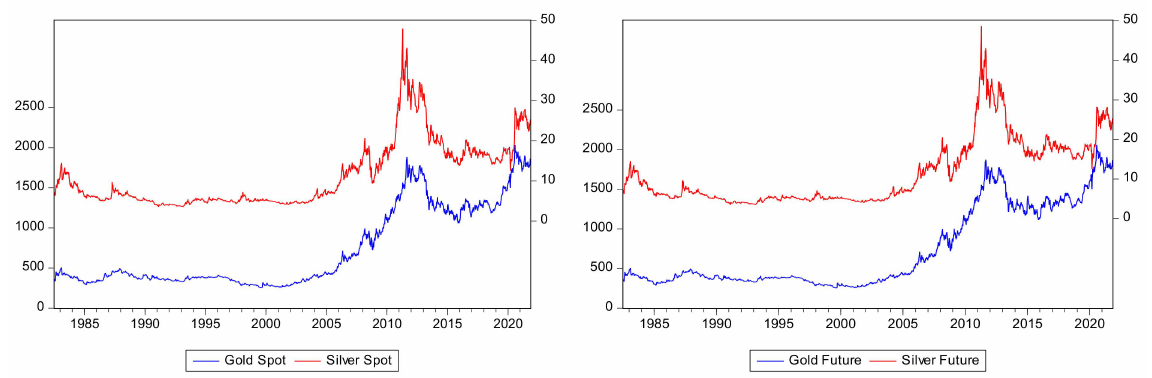
Figure 1. Gold and Silver Spot and Future prices. As we can see both markets show similar patterns and trends although the silver spikes seem to be more pronounced. The return in the two markets have been calculated as − X ) / X ( X 2 1 , where X i is the price of the commodity (spot or future) in the i period. 1 Returns are shown in Figure 2: